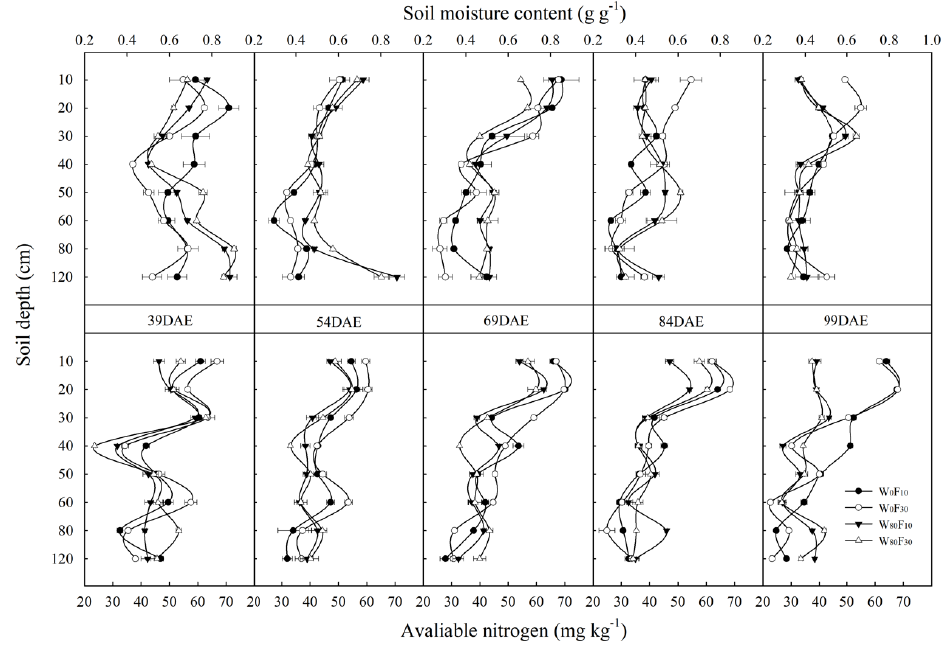
Figure 2. Changes in the soil moisture and the available nitrogen in different vertical soil layer (from 0 to 120 cm soil layer) at pre-sowing irrigation (W 80 ) or no pre-sowing irrigation (W 0 ) and base fertilizer surface (F 10 ) or deep (F 30 ) application with the days after emergence in 2016. Bars indicate SD ( n = 3).